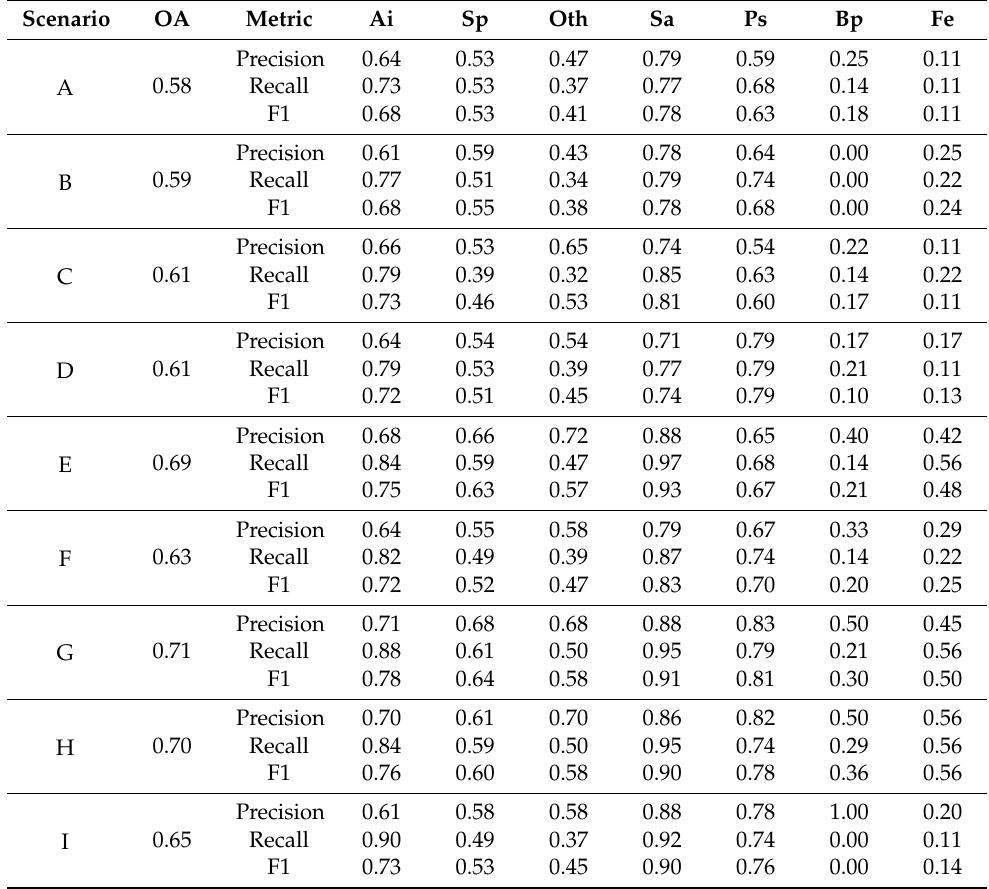
Table 11. Results of the LOOCV for the nine proposed scenarios. OA = overall accuracy. Refer to Table 4 for the species